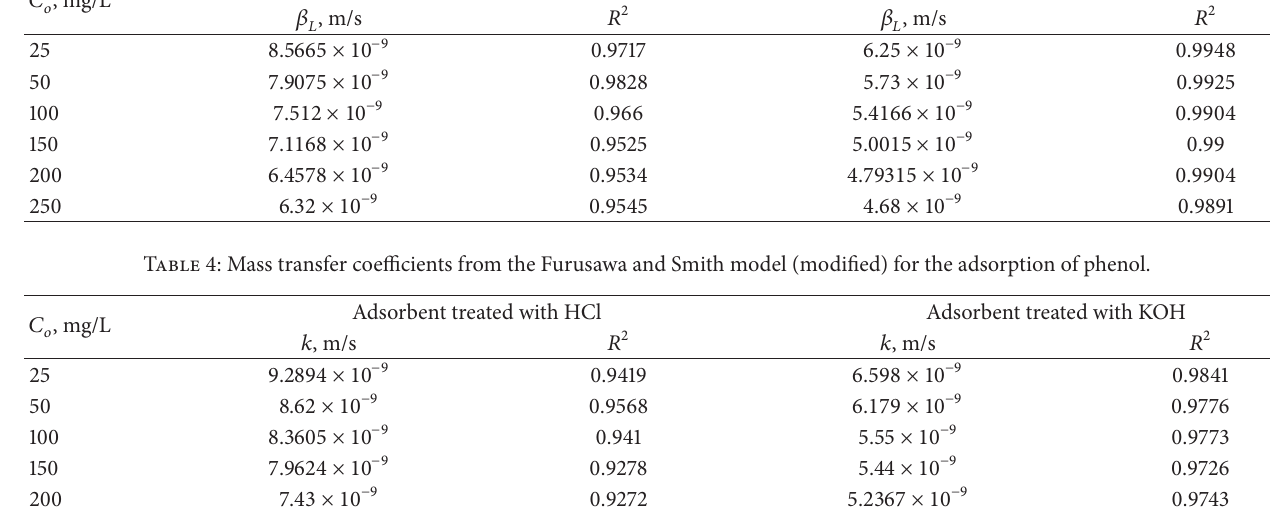
Table 3: Mass transfer coefficients from the Furusawa and Smith model for the adsorption of phenol. 𝐶 𝑜 , mg/L